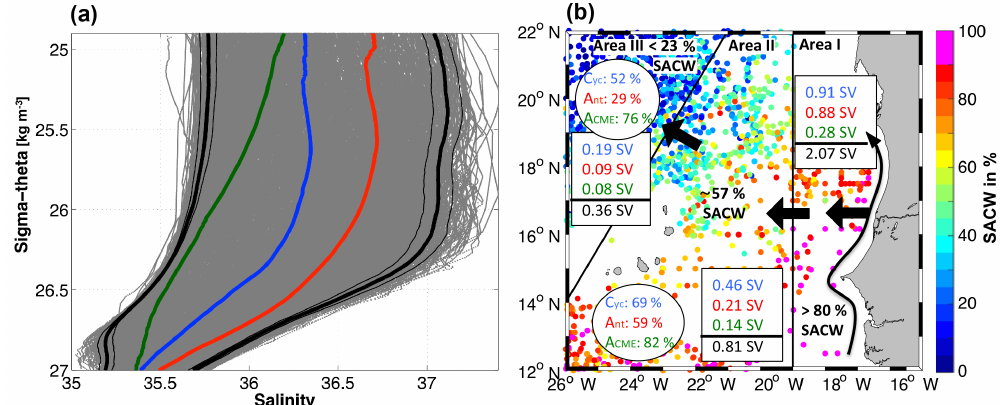
Figure 16. (a) S - σ θ diagram with thick and thin black lines indicating mean and standard deviation, respectively, of characteristic SACW and NACW properties derived from the ensemble of profiles taken in the TANWA (gray lines). Mean eddy-dependent water mass properties are given for cyclones (blue line), anticyclones (red line), and ACMEs (green line). (b) Percentage of SACW in the upper 350m as shown for all available profiles (color) and as mean numbers for the three regions: the extended boundary current region (area I), the transition zone (area II), and the subtropical gyre region (area III) that are separated by black straight lines. Numbers in the white circles are the mean percentage of SACW of the composite cyclones (blue), anticyclones (red), and ACMEs (green) in the corresponding areas. The eddy transport of SACW from the boundary current into area I, from area I into area II, and from area II into area III is marked by thick black arrows with transport numbers in Sv given in the white boxes for composite cyclones (blue), anticyclones (red), ACMEs (green), and total transport (black).